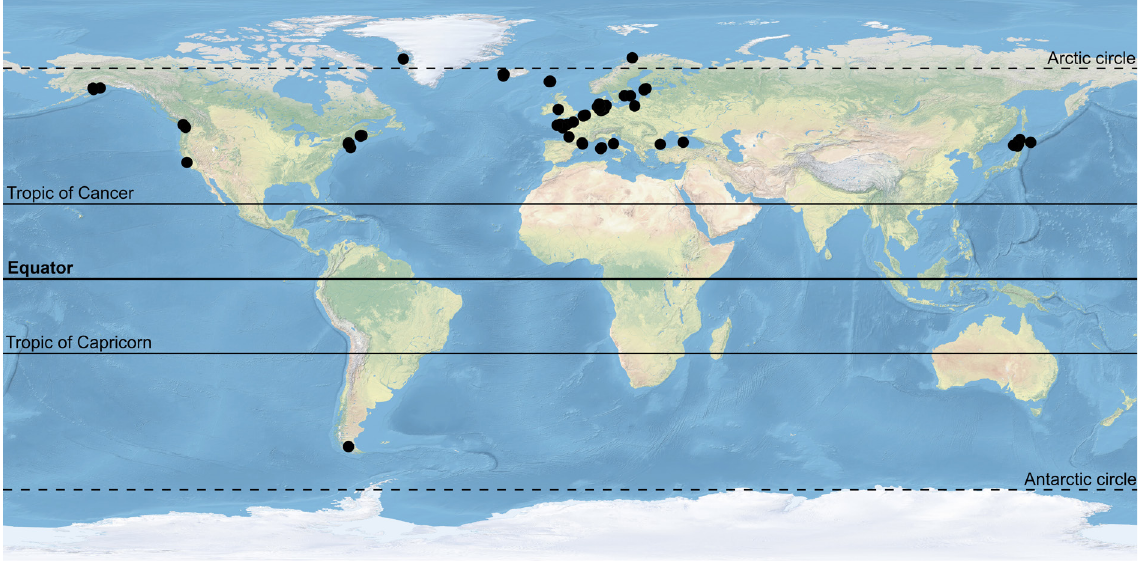
Fig. 6. Map showing the known distribution of the genus Coelogynopora based on all the available reports, which may be summarised by Karling (1966), Sopott-Ehlers (1976, 1992), Tajika (1978, 1981), Riser (1981), Ax & Armonies (1987), Ax (2008), Armonies (2017, 2018), Jouk et al . (2019), and this